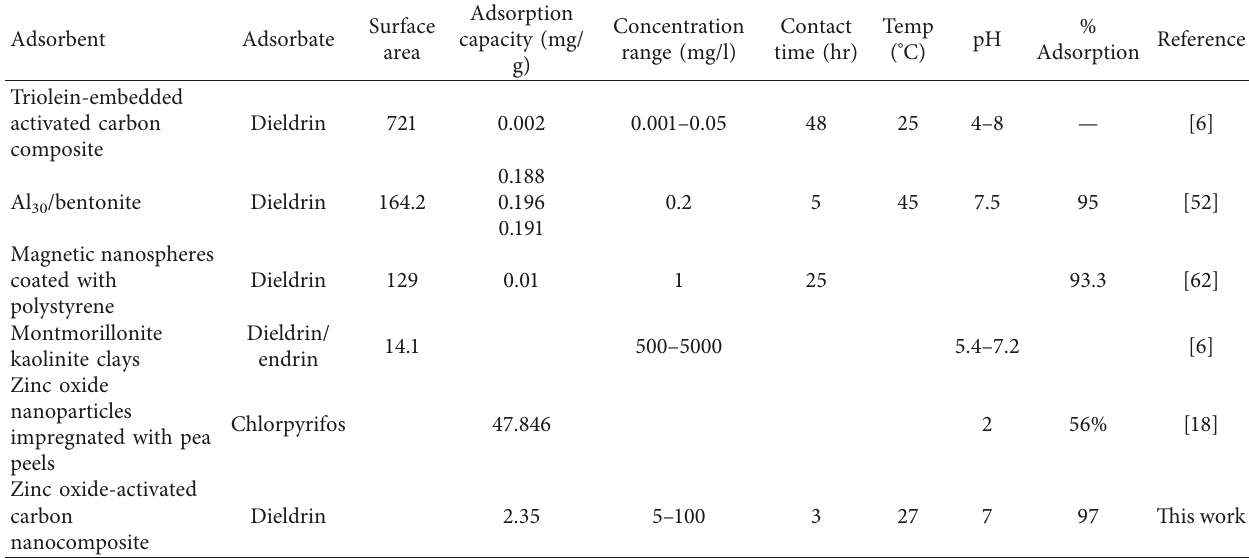
Table 6: Comparison of adsorption capacities and other parameters for the removal of dieldrin in different adsorbent materials.